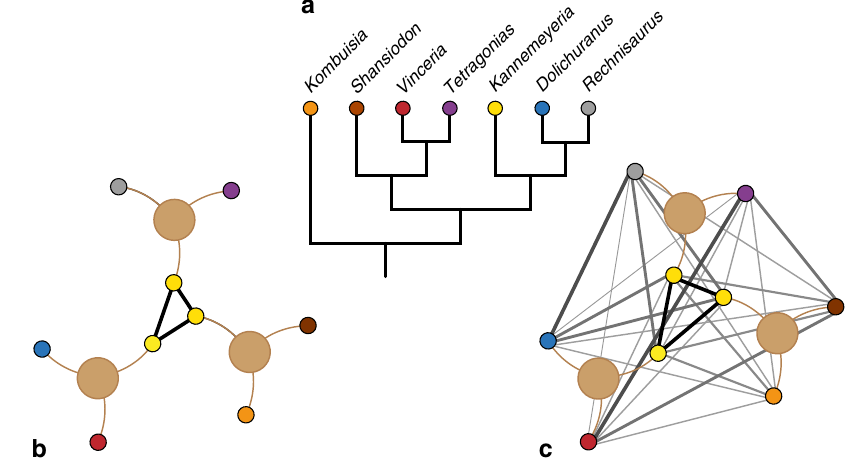
Fig. 1 Schematic illustration of network biogeography methods. a Simpli fi ed phylogeny of Dicynodontia. b , c Taxon-locality networks. Localities are indicated by the large, pale brown circles, taxa are coloured as in ( a ). Taxa are connected by brown lines to the locality at which they occur. b Rescaled non-phylogenetic biogeographic connectedness (BC) of Sidor et al. 3 . A single taxon, Kannemeyeria ( yellow ), is present at all three localities, resulting in a link of value = 1 ( solid black line ) between each locality. c Phylogenetic biogeographic connectedness (pBC), as proposed here. Links ( grey lines ) between taxa from different localities are weighted inversely to their phylogenetic relatedness. Line thickness and shade is proportional to the strength of the link (and thus inversely proportional to phylogenetic distance between the two